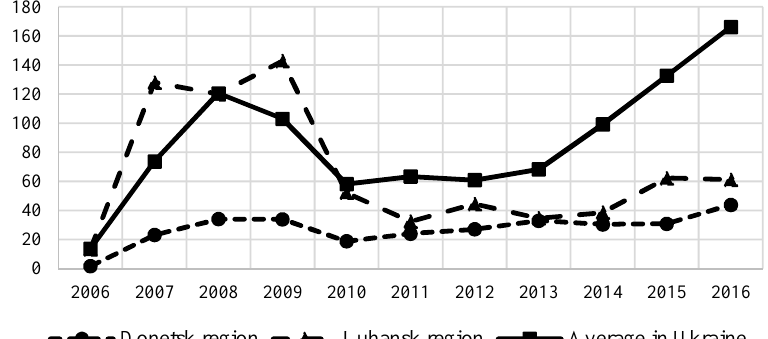
Figure 4. Dynamics of ecological expenses to produced waste in Luhansk and Donetsk regions compared to average value in